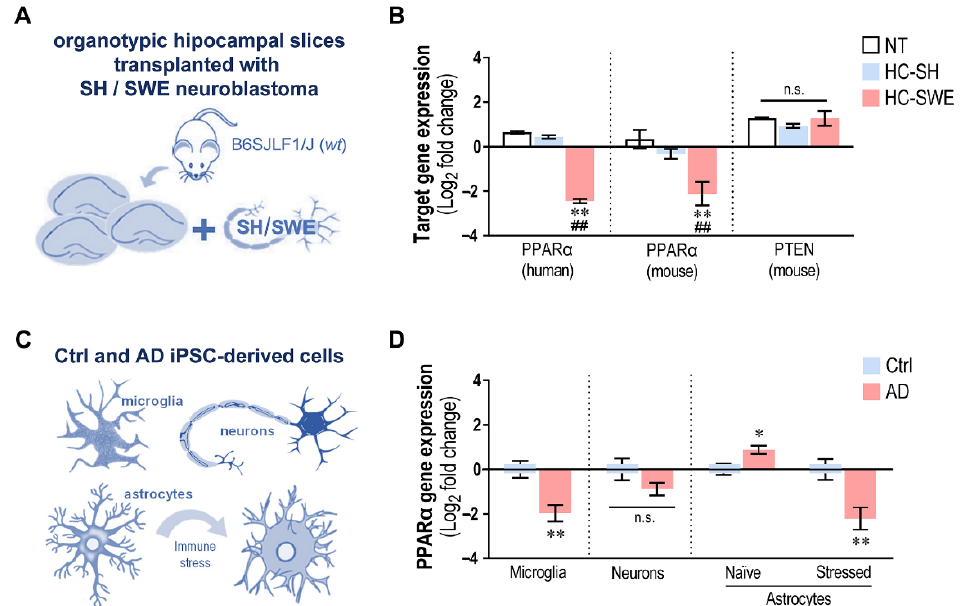
Figure 9. Gene expression of the miR-21 target PPAR α is repressed in SWE-transplanted organotypic hippocampal cultures, in AD iPSC-derived microglia and in stressed iPSC-derived AD astrocytes. ( A ) Schematic representation of hippocampal xenotransplantation with the ( B ) respective gene expression of miR-21 targets: human PPAR α , mouse PPAR α and mouse PTEN in NT, HC-SH and HC-SWE slices. ( C ) Schematic representation of Ctrl and AD iPSC-derived microglia, neurons and astrocytes. Astrocytes were also immunostimulated with C1q + IL-1 α + TNF- α cocktail, as detailed in Materials and Methods. ( D ) Gene expression of PPAR α in iPSC-derived microglia, neurons and astrocytes (naïve and stressed) from AD patients vs. respective control (Ctrl) cells. Results are mean ± SEM from at least 4 independent experiments, expressed as the binary logarithm of fold change. Two-tailed Student’s t -test: * p < 0.05 and ** p < 0.01 vs. NT/Ctrl; ## p < 0.01 vs. HC-SH. ( B ) or respective Ctrl cells ( D ). SH, SH-SY5Y neuroblastoma cells; SWE, SH-SY5Y neuroblastoma cells expressing the human APP695 Swedish mutation; NT, non-transplanted hippocampal slices; HC-SH, hippocampal cultures with engrafted SH cells; HC-SWE, hippocampal cultures with engrafted SWE cells; AD, Alzheimer’s disease; Ctrl, control; PPAR α , peroxisome proliferator-activated receptor alpha; PTEN, phosphatase and tensin